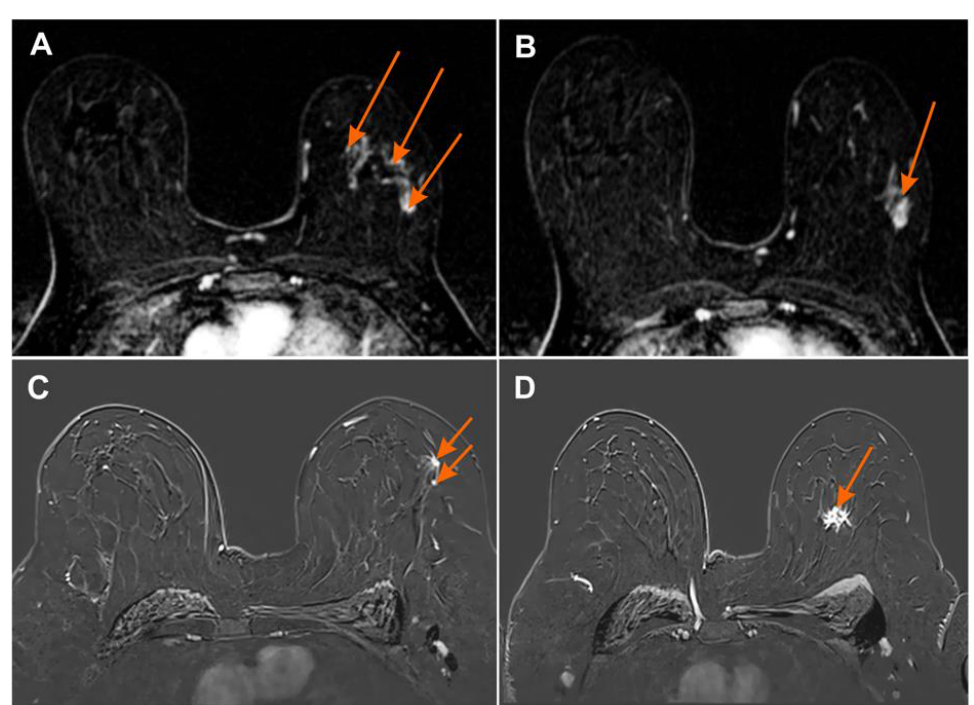
Figure 3. Contrast-enhanced spectral mammography (CESM)subtraction images: ( A ) craniocaudal ( CC ) and ( B ) mediola- teral oblique (MLO) views — irregular mass with heterogeneous enhancement and long spiculated mass BI-RADS 6. Nu- merous enhanced small foci are noted in left breast BI-RADS 4 (orange arrows); ( C ) craniocaudal (CC) and ( D ) mediola- teral oblique (MLO) views — irregular mass with heterogeneous enhancement and long spiculated mass BI-RADS 6. Ad- ditional enhanced small foci are noted in the left breast in superior-outer quadrant BI-RADS 4 (orange arrows).